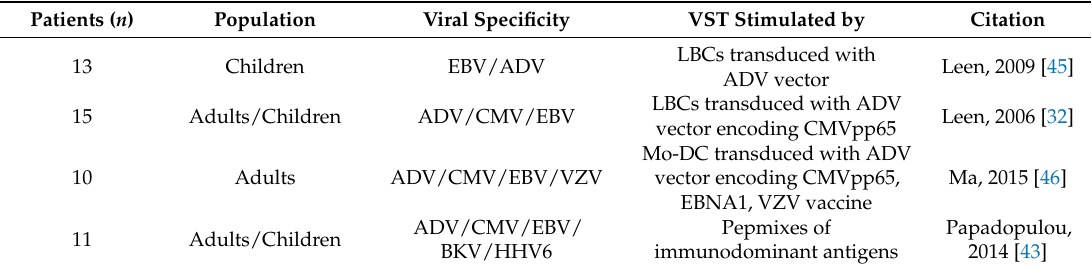
Table 3. Largest published clinical trials for treatment and prevention of viral reactivation after HSCT using donor-derived multiple-virus adaptive